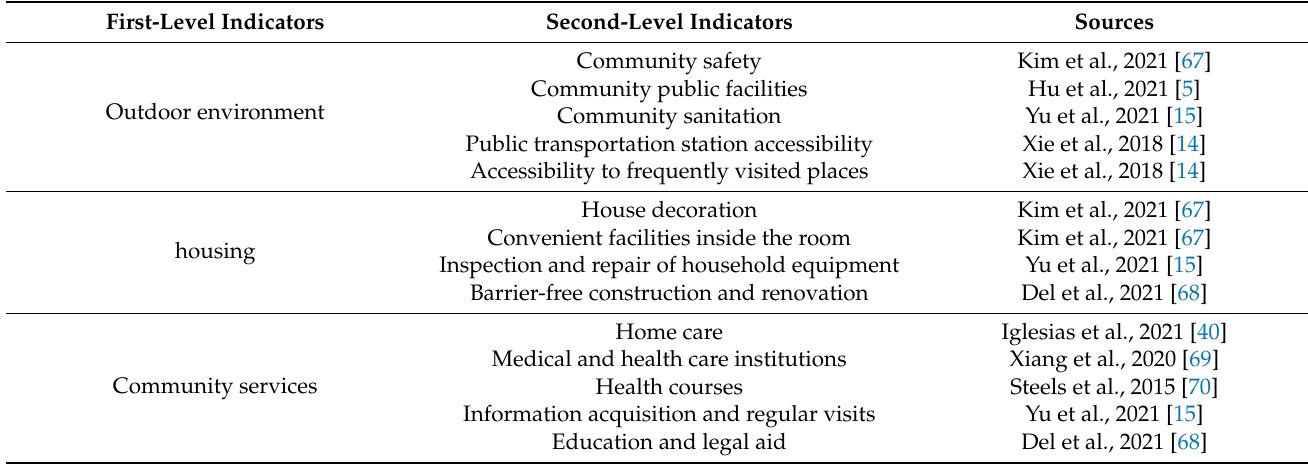
Table 1. Environmental demand indicators experienced by